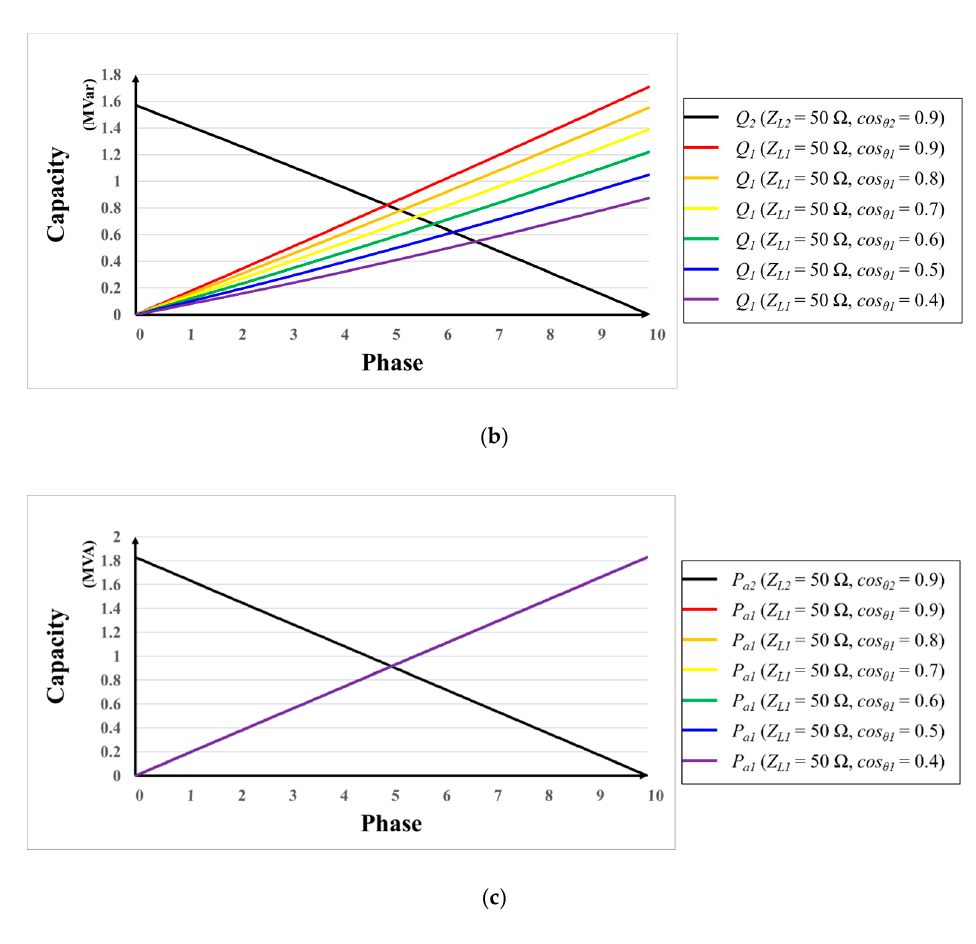
Figure 5. APC capacity according to power factor change when the load impedance is constant. ( a ) Active power; ( b ) reactive power; ( c ) apparent power.